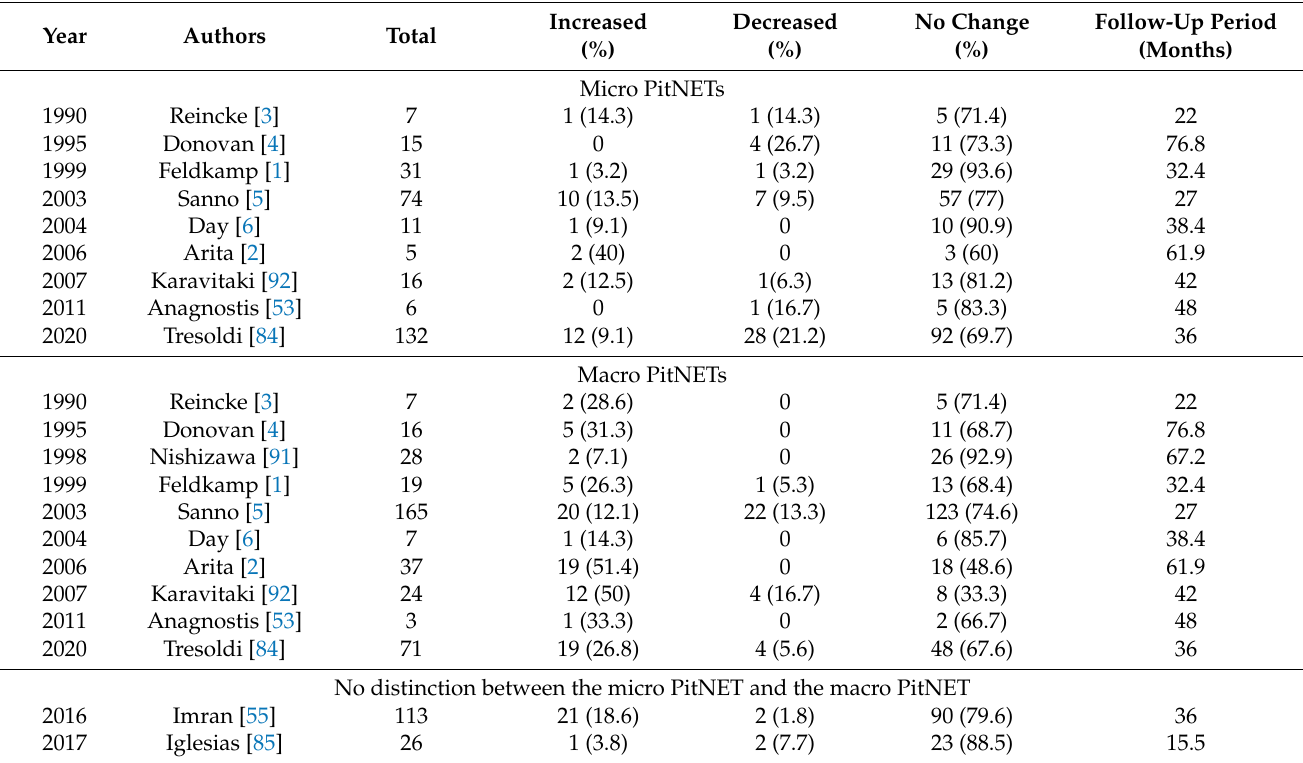
Table 4. Tumor size changes in pituitary incidentalomas with an estimated diagnosis of